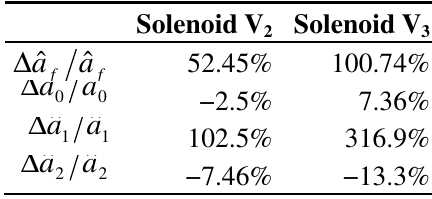
Table 1 . Parameter changes of the solenoid